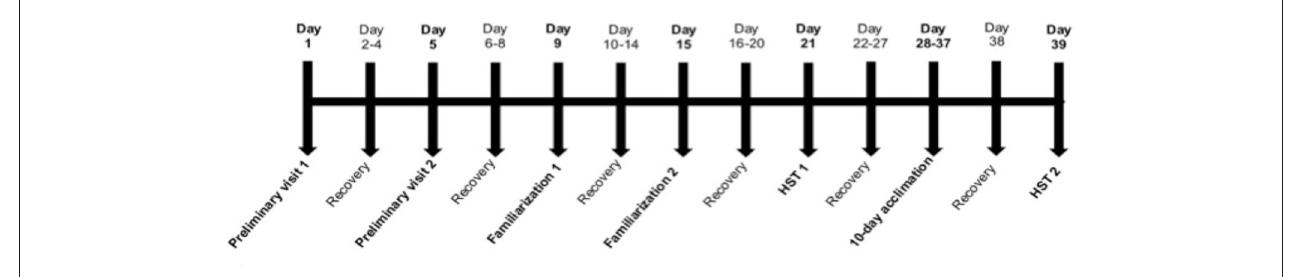
FIGURE 1 | Schematic of the experimental design. Participants attended the laboratory a total of 16 times over ∼ 39 days. Preliminary assessments of normoxic and hypoxic ˙ V O 2 peak were performed in a counterbalanced order separated by at least 3 days. After at least 3 days’ recovery (range 3–7 days) participants completed a full familiarization visit under normoxic conditions, followed 6 days (range 6–11) later by a second familiarization, from which the normoxic stress test (NST) data was obtained. At least 6 days after the NST (range 6–9 days), participants completed the pre-acclimation hypoxic stress test (HST1). Following a “wash out” period of 7 days (range 7–11 days), participants commenced 10 consecutive days of exercise acclimation. A second, post-acclimation HST (HST2) was performed 48h after the final acclimation session in all